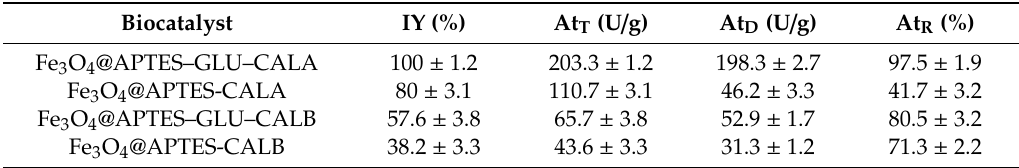
Table 1. Immobilization parameters of CALA and CALB: immobilization yield (IY),